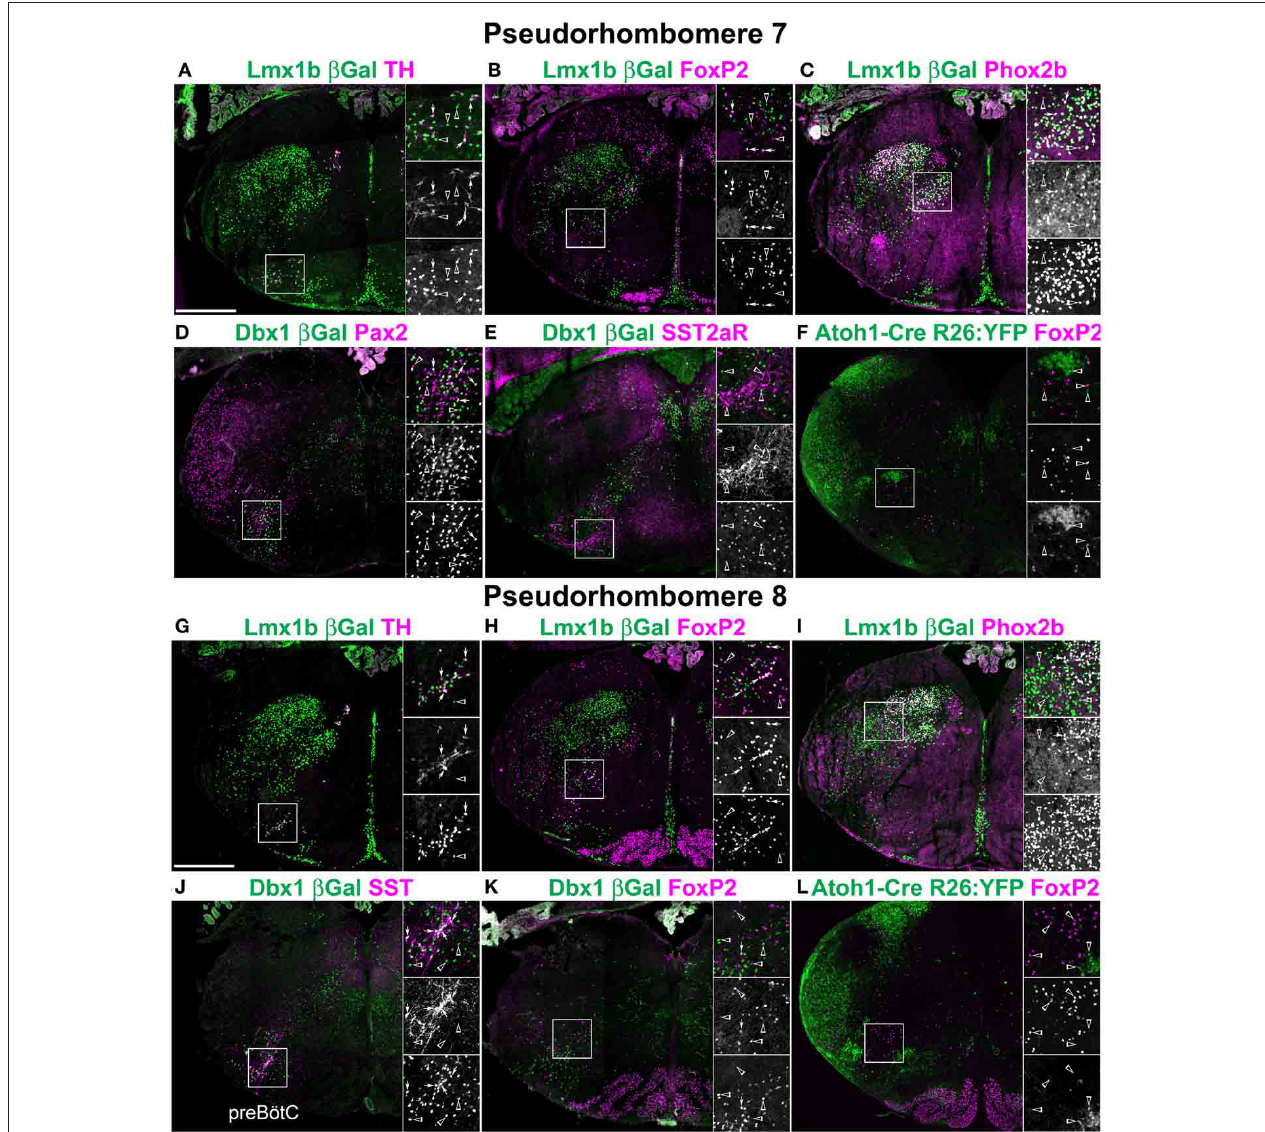
FIGURE 3 | Segmental organization of combinatorial patterns of gene expression within rostral medulla hindbrain lineages. Pseudo-color fluorescent confocal mosaic hemi-sections from P0 transgenic mice at the level of pseudo-rhombomere7 (A–F) and 8 (G–L) . Images from Lmx1b- β gal (A–C,G–I) , Dbx1- β gal (D,E,J,K) , and Atoh1 -Cre; R26YFP (F,L) mice showing localization of lineage reporter (green) β -Gal (A–E,G–K) or YFP (F,L) with